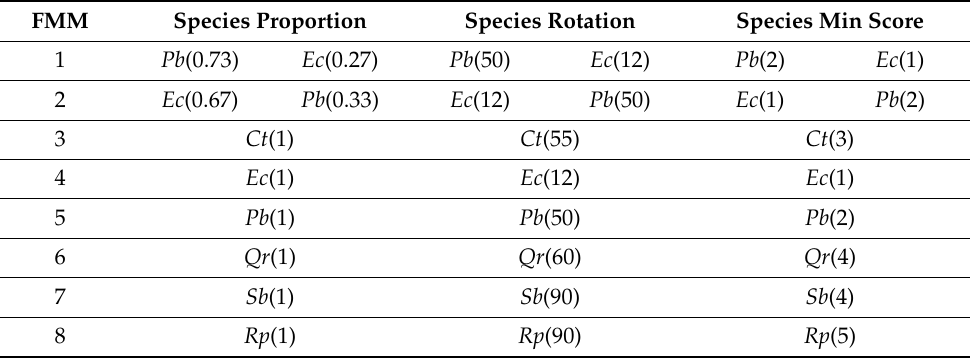
Table 3. Species proportion, rotation and minimum values used to define biodiversity scores at stand-scale. FMM Species Proportion Species